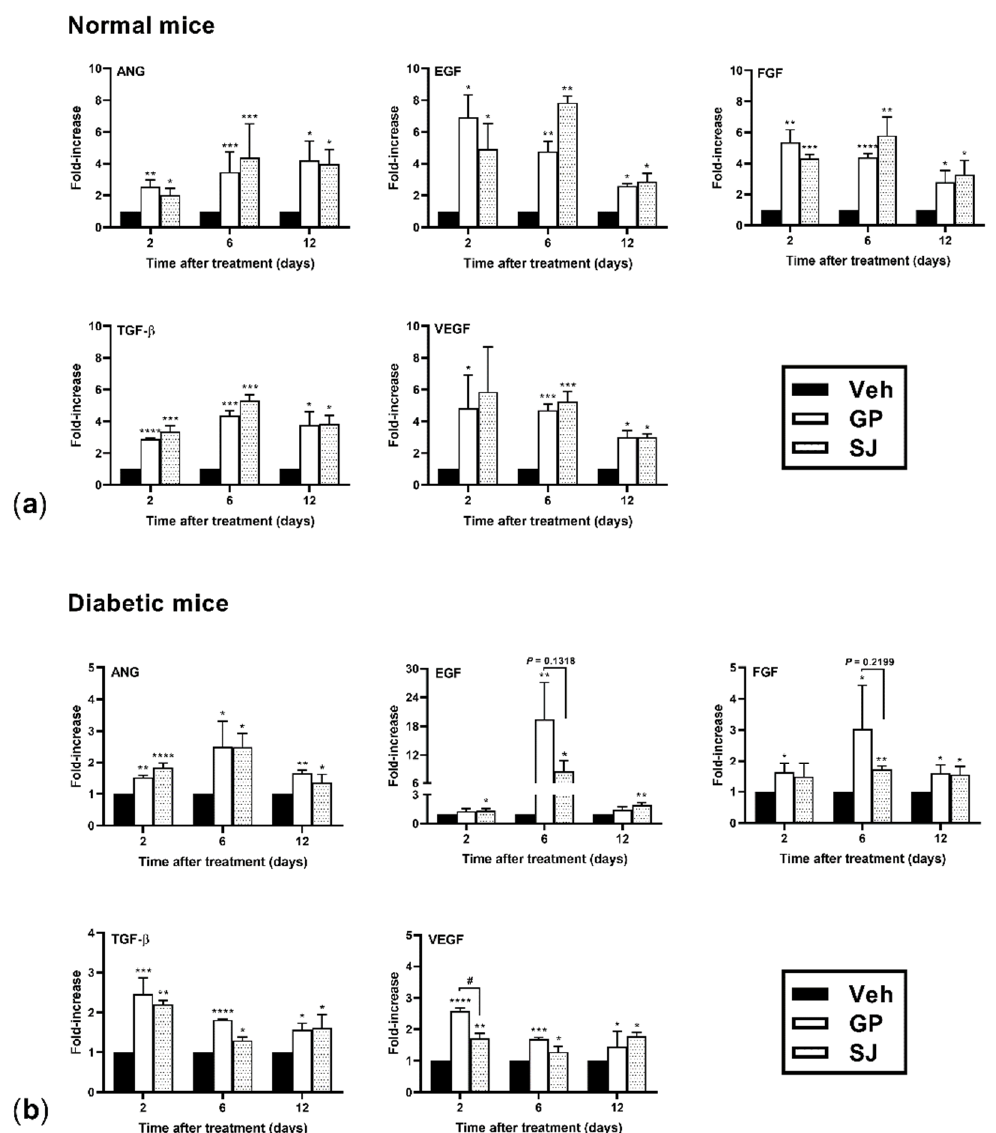
Figure 3. G. procumbens induces genes involved in wound healing in the normal and diabetic mice: The mRNA expression of ANG, EGF, FGF, TGF- β and VEGF in wounded skin from ( a ) normal mice and ( b ) diabetic mice treated with Vaseline (Veh: vehicle), 0.5% G. procumbens (GP) or 10% solcoseryl jelly (SJ) for 2–12 days (n = 5). * p < 0.05, ** p < 0.01, *** p < 0.001 and **** p < 0.0001 for the comparison between Vaseline (Veh: vehicle) and G. procumbens (GP) or solcoseryl jelly (SJ). # p < 0.05 for the comparison between G. procumbens (GP) and solcoseryl jelly (SJ).